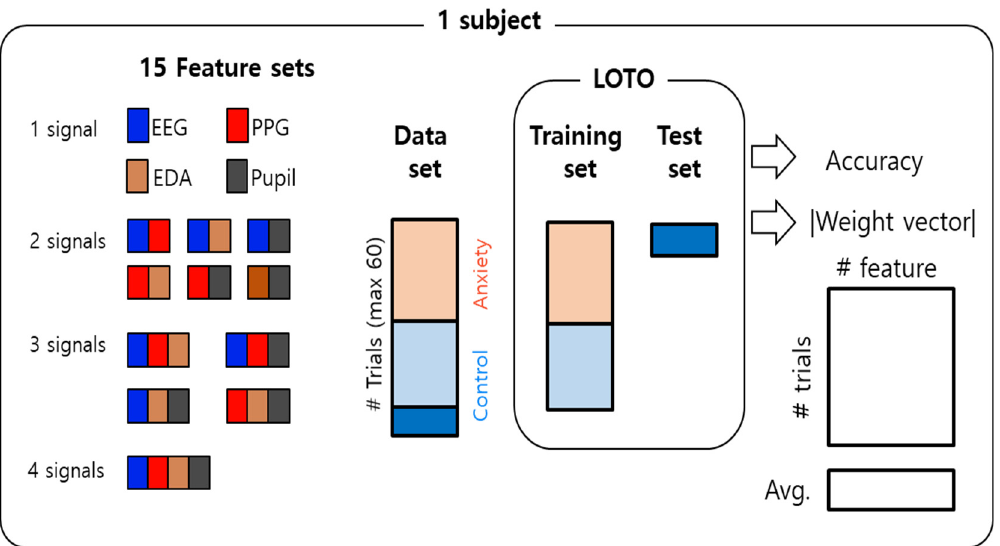
Figure 5. The description of leave-one-trial-out (LOTO) within 1 subject.